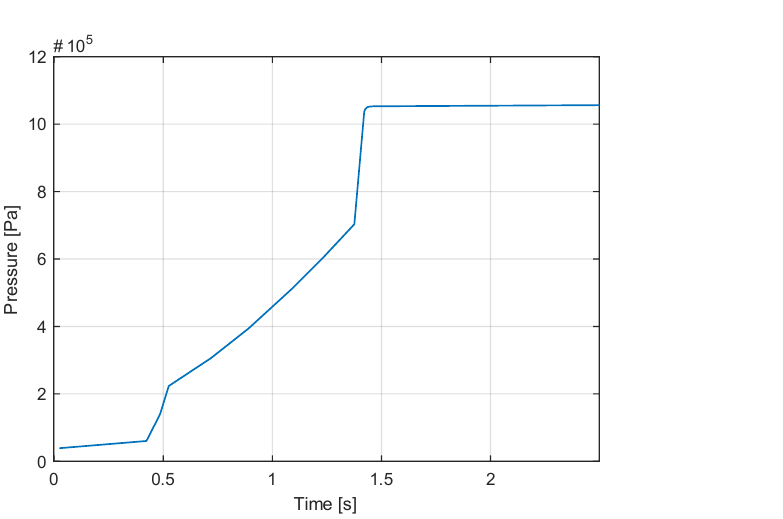
Figure 5 – Simulation results in MATLAB/Simulink Рис. 5 – Результаты моделирования в MATLAB/Simulink Слика 5 – Резултат добијен симулацијом у